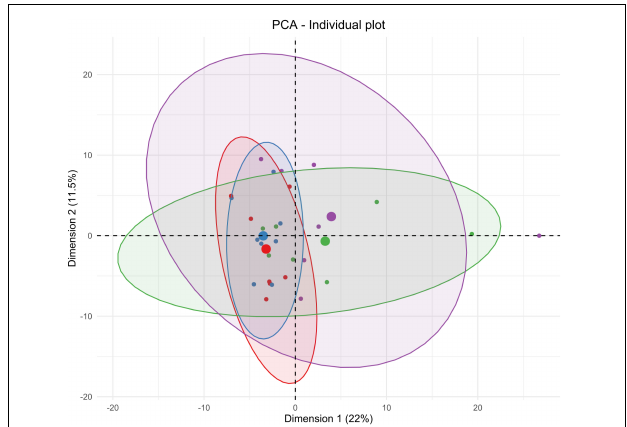
FIGURE 5 | Unsupervised multivariate analyses on blood serum metabolome between control and insonified groups. Score plot of principal component analysis (PCA) constructed with metabolites within the blood serum metabolome after acoustically-mediated BBB opening (BBBO). Larger dots are inertial centers of ellipses (center of a sample group) plotted based on smaller dots representing each sample individually. Red dots are control samples; Blue dots are 3-h post-BBBO samples; Green dots are 2-days post-BBBO samples; Purple dots are 1-week post-BBBO samples. Two samples having the same metabolic profile will be clustered in the same dimensional